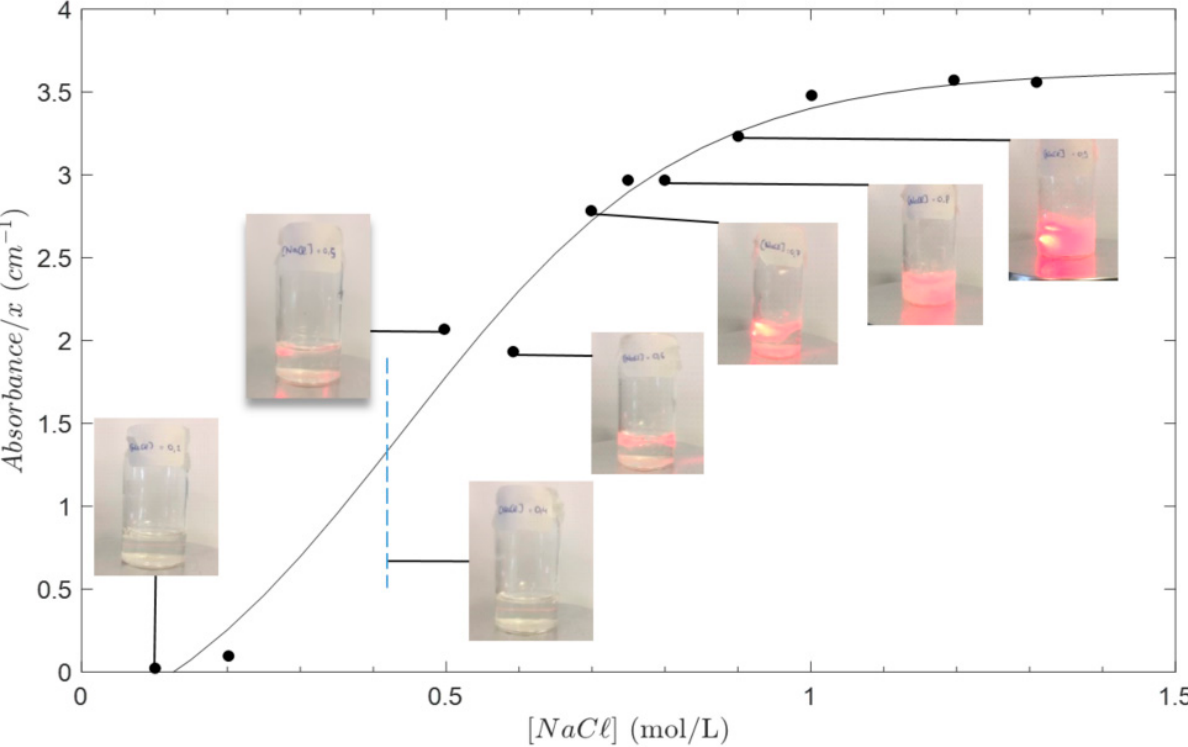
Figure 1. Solubility study of chitosan acetate solutions with added NaCl. The concentration of chitosan was 3% w / w . Solubility is quantified by the evolution of absorbance at 400 nm (adapted from [40]), and precipitation is displayed by images of the samples submitted to a laser beam ( λ = 650 nm). Solubility of chitosan acetate in saline aqueous solution was limited to the NaCl concentration range from 0 to 0.4 M.